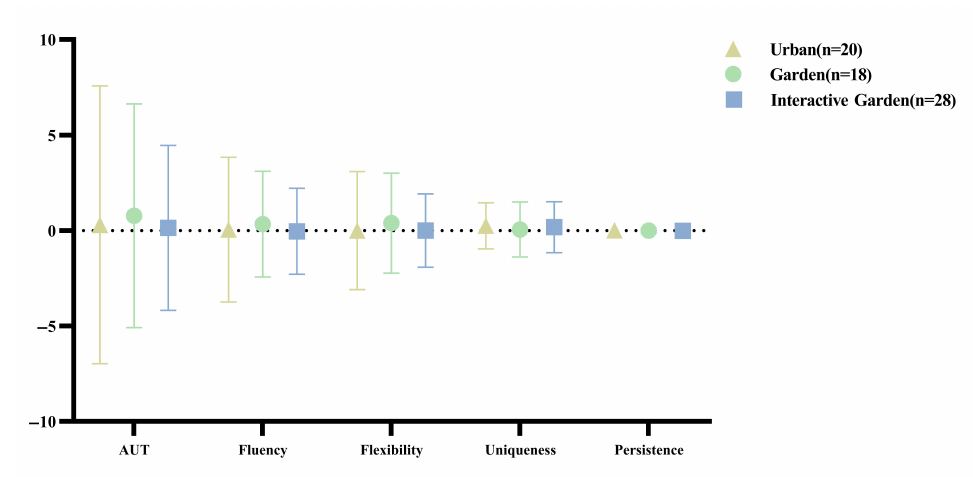
Figure 4. Descriptive statistical results of the scores of